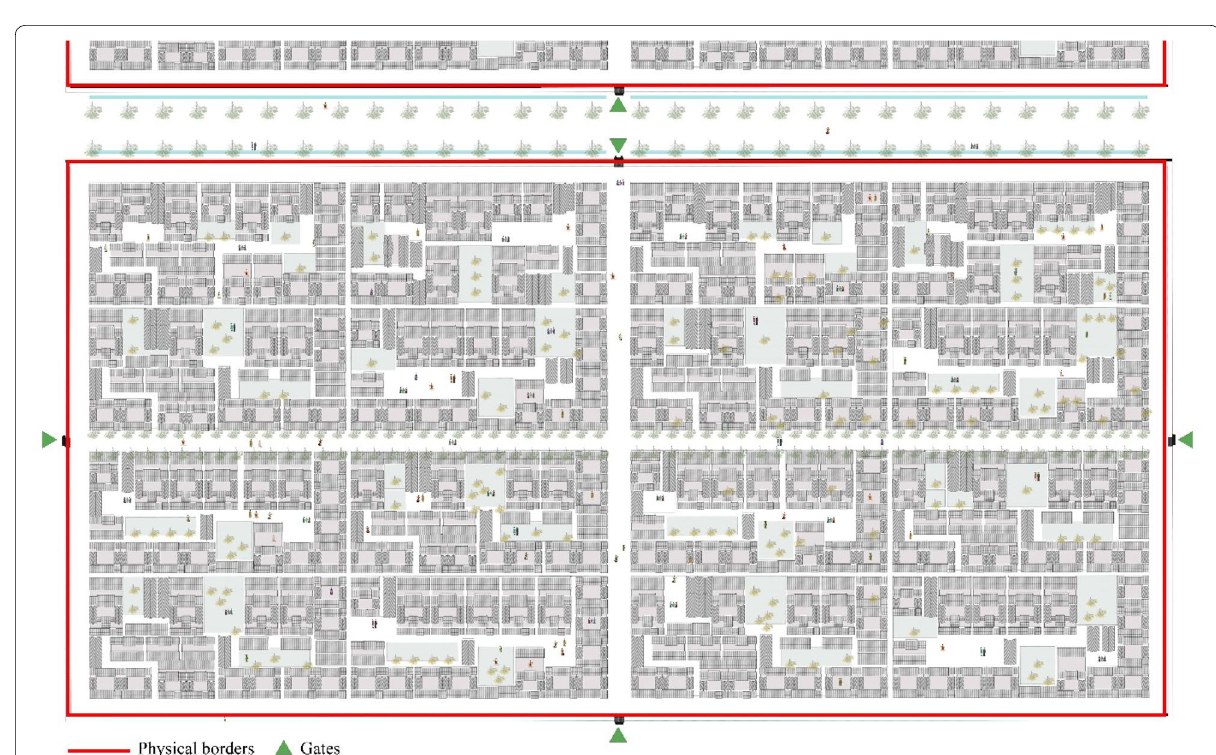
Fig. 2 Axonometric view of a typical residential ward of sixteen sectors. Each residential ward, was walled and gated and subdivided into different sectors and land parcels through the internal road networks. Wards had different dimensions, the smallest one could range between 500 and the largest one 1000 500 m (Source: Hamama ×